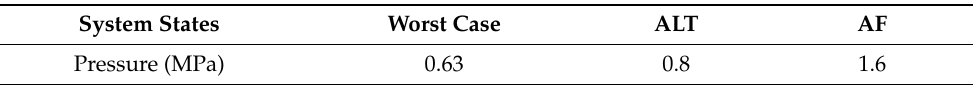
Table 3. Pneumatic cylinder ALT